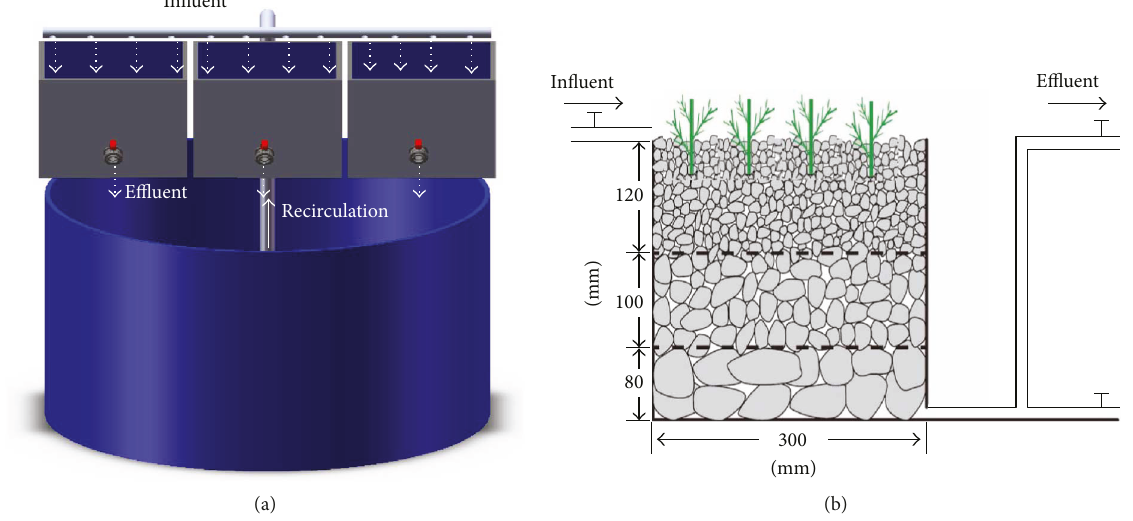
Figure 1: The pilot CW system (a) and a single CW unit (b). (Figure (b) was adapted from Li et al. (unpublished data)